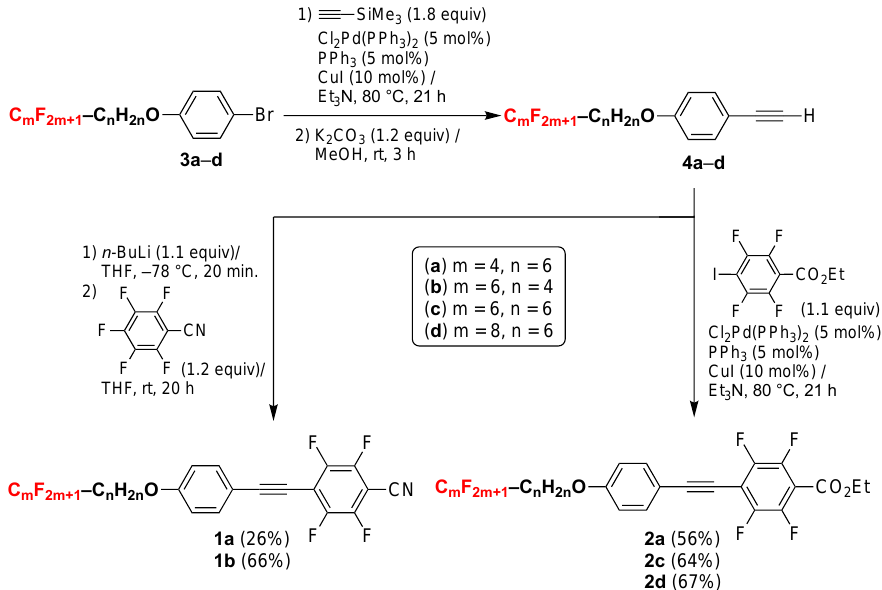
Scheme 1. Synthesis scheme of semifluoroalkoxy-containing D- π -A-type fluorinated diphenylacetylenes 1 and 2 .